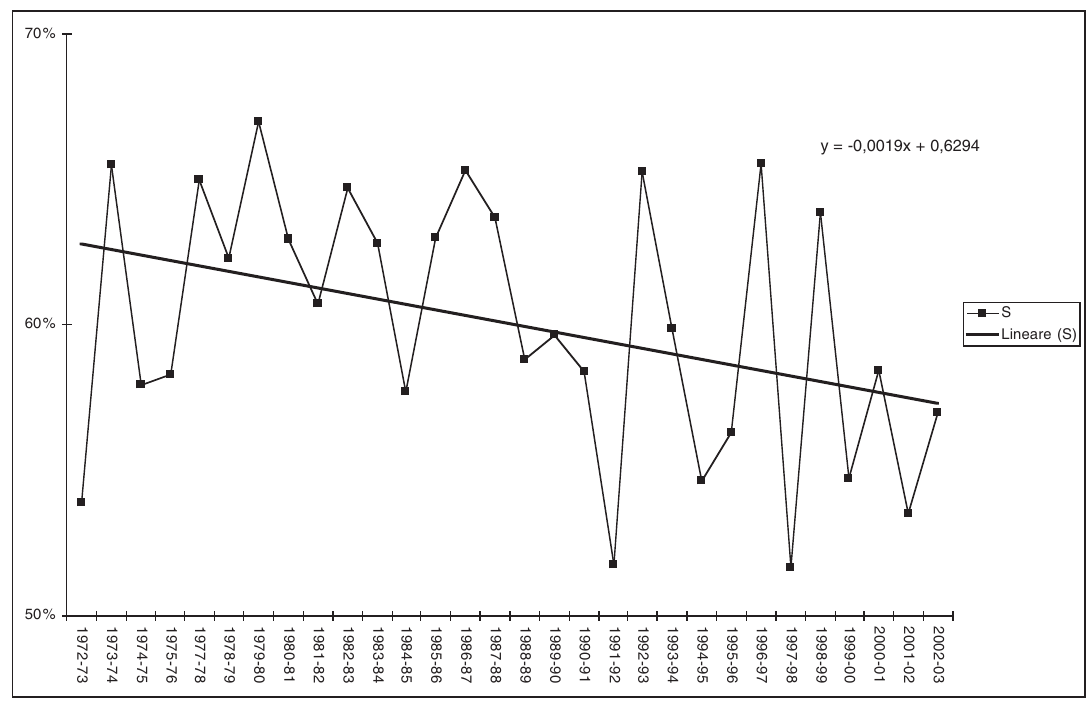
Figura 1 – L’indice complessivo S ,